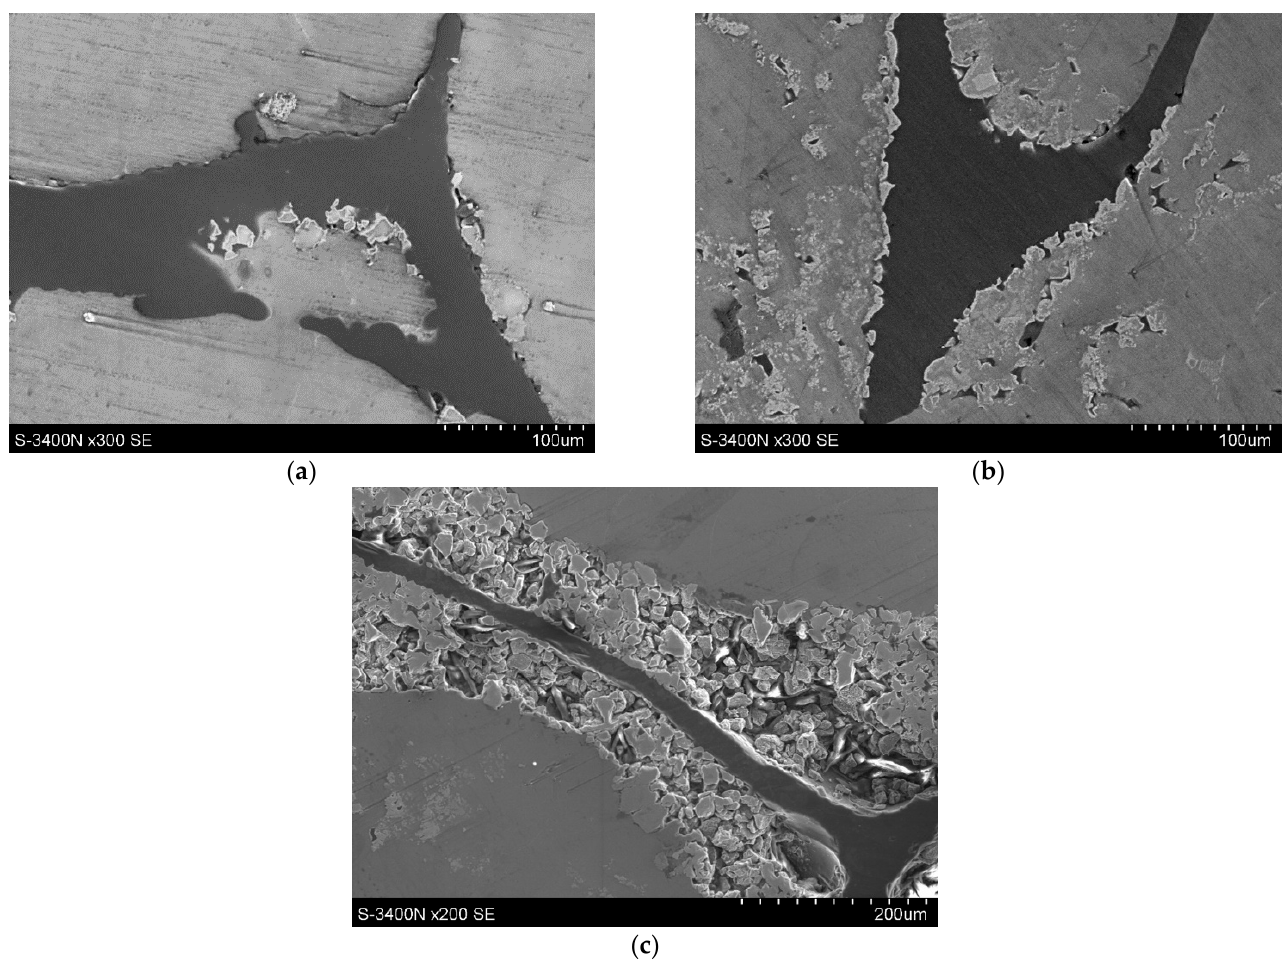
Figure 8. The microstructure of composites obtained by infiltration of spatial structures with a range of Ti particle suspensions: ( a ) 5 vol.%; ( b ) 20 vol.%; ( c ) 40 vol.% used for Ti layer creation (SEM).